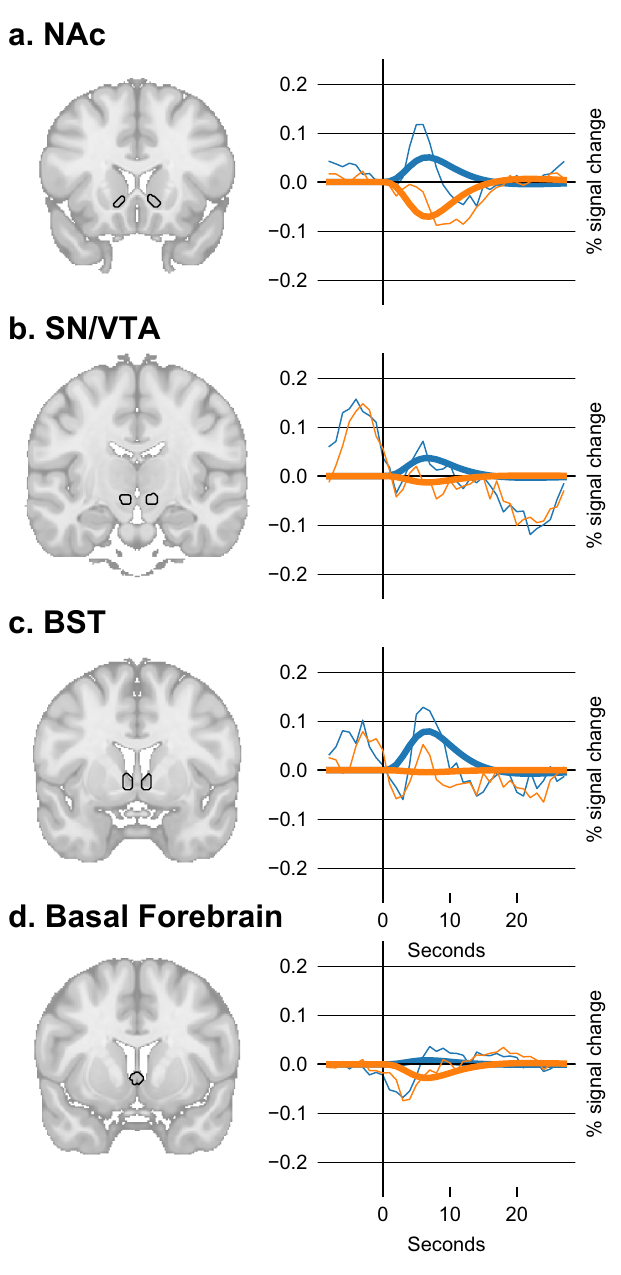
Fig. 4 More activity for the trustworthy (blue) vs. untrustworthy player (orange) during the outcome event found in the secondary analyses. a In the nucleus accumbens (NAc), t = + 6.3, p < 0.0001, b Substantia nigra (SN) and ventral tegmental area (VTA), t = + 3.7, p = 0.0005, c Bed nucleus of the stria terminalis (BST), t = + 4.00, p = 0.0002, and ( d ) the septal part of the basal forebrain, t = 2.1, p = 0.0361. Thick lines represent the estimated BOLD